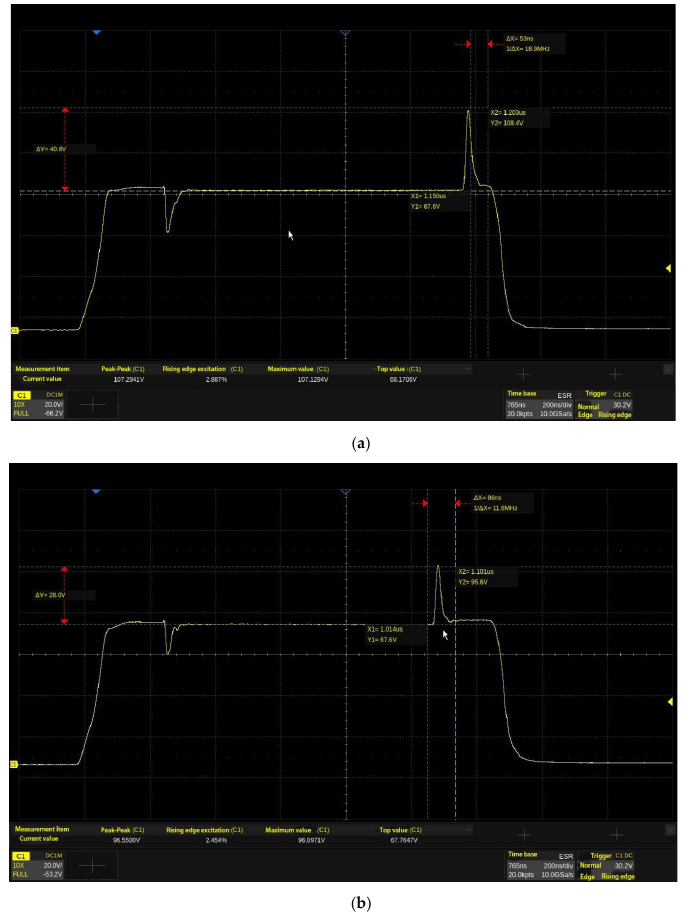
Figure 16. The measured voltage waveform of the bias circuit of the power-amplifier system. ( a ) The traditional power-amplifier system. ( b ) The proposed power-amplifier system. The measurement ratio is slightly larger than the simulation ratio, because the con- nection wire and solder in the simulation model are not the same as the actual connection line and solder.